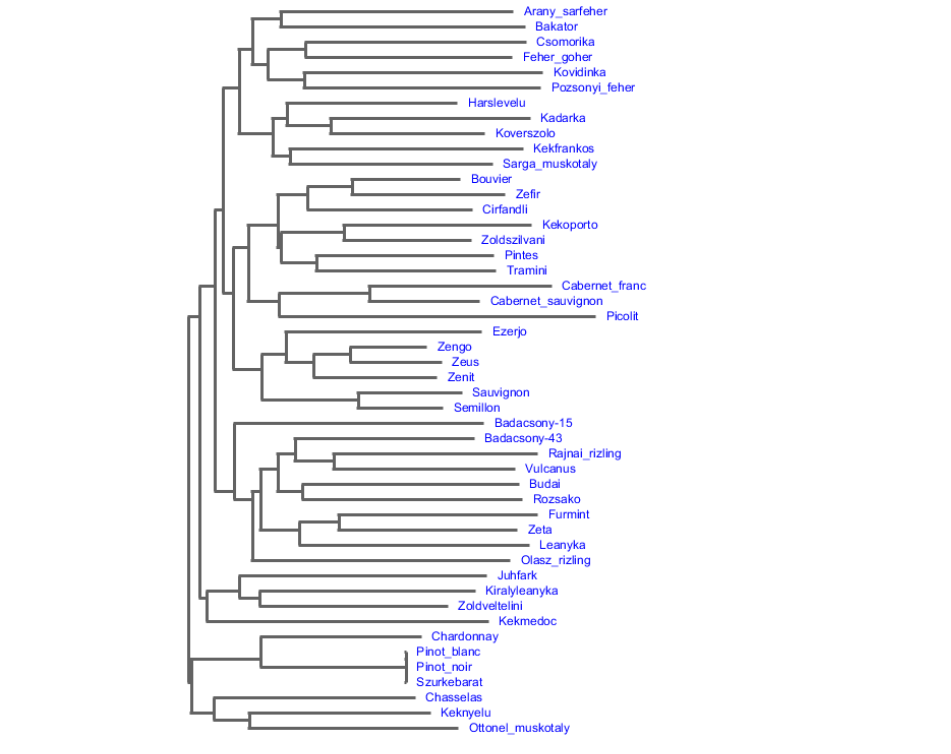
Figure 6. Neighbor-Joining dendrogram using Jaccard similarities displayed by MolMarker.